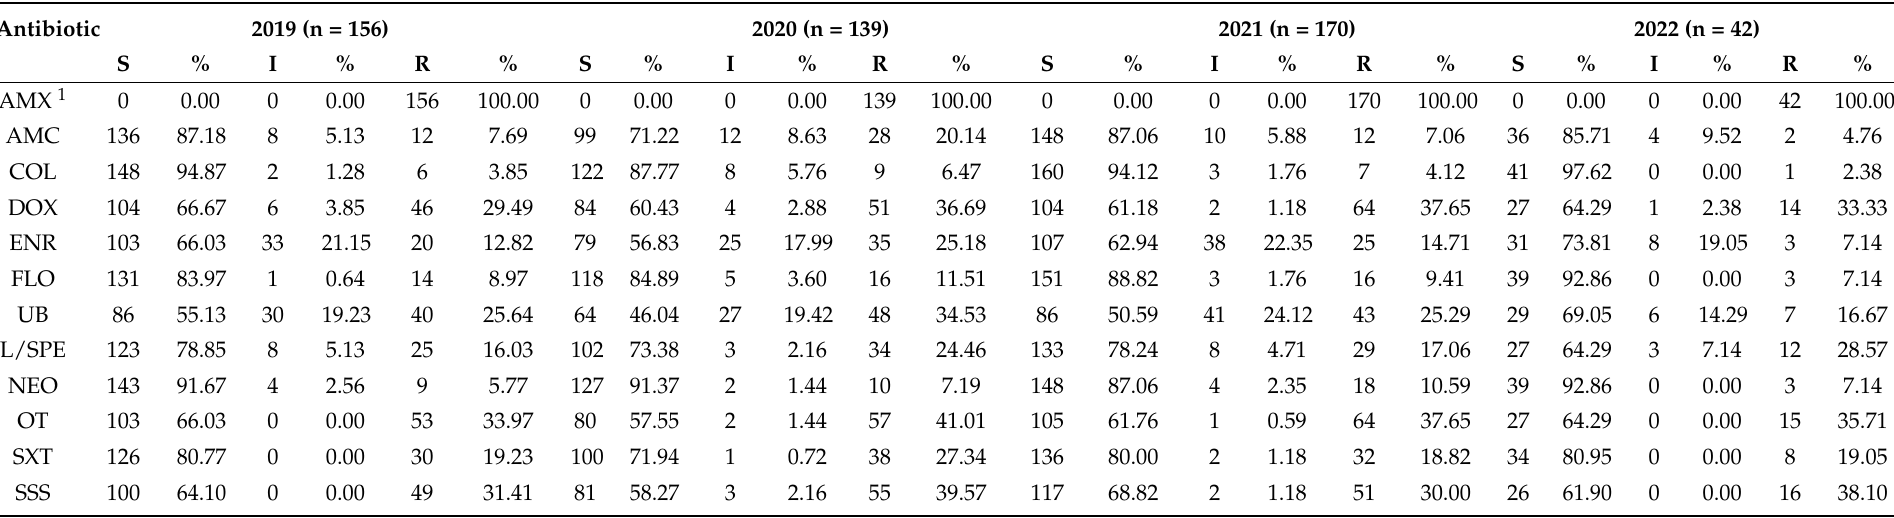
Table 2. Antibiotic susceptibility of Klebsiella spp. strains isolated from turkeys in